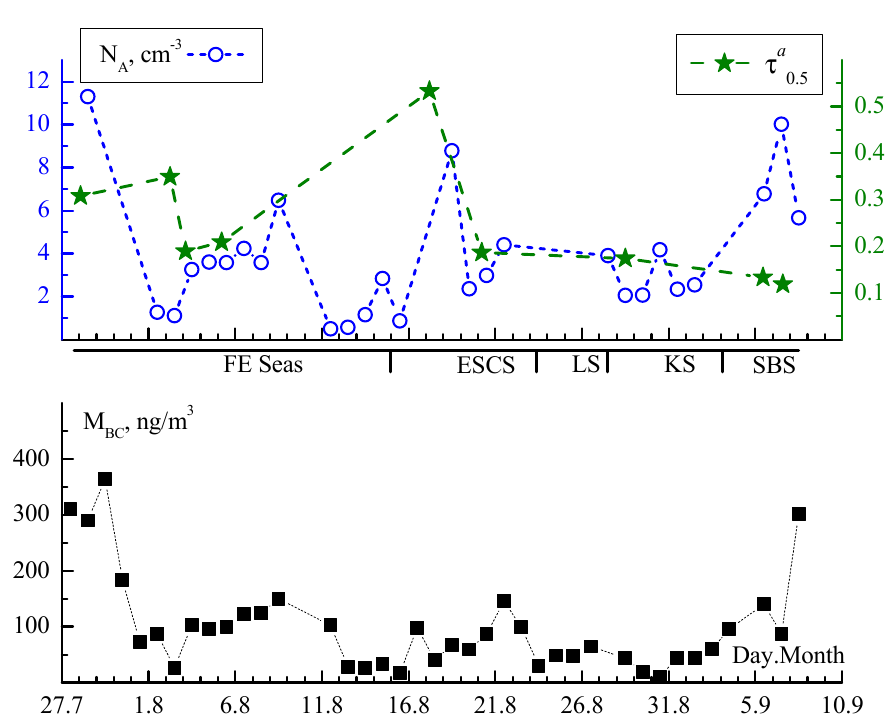
Figure 8. Variations in daily average concentrations N A , M BC , and in AOD in expedition of RV Professor Multanovskiy.